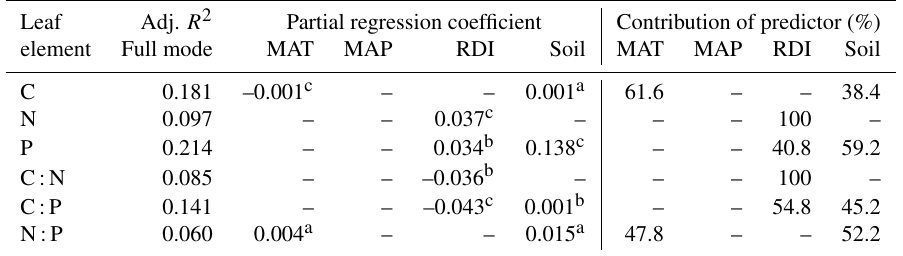
Table 2. Model summary for the stepwise multiple regression (SMR) of leaf element concentrations and ratios of all shrub samples on climatic and soil variables (MAT, MAP, RDI, soil element and ratio).